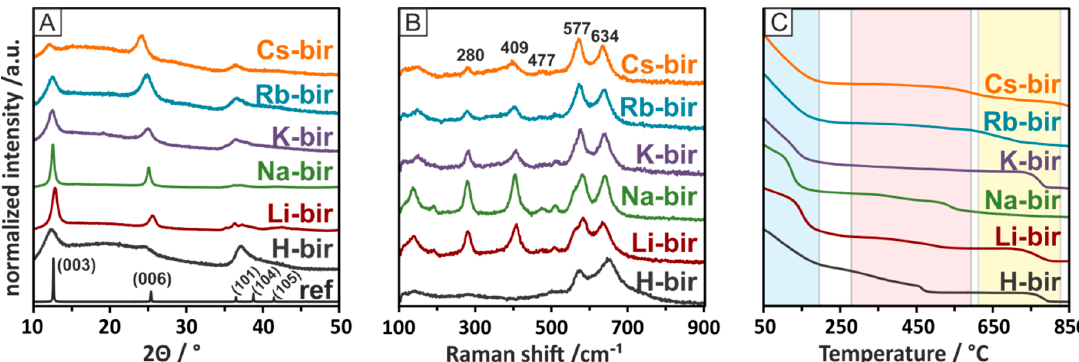
Figure 2. Diffractograms ( A ), Raman spectra ( B ), and mass loss derived from thermogravimmentric analysis ( C ) for bulk alkali-promoted birnessite.